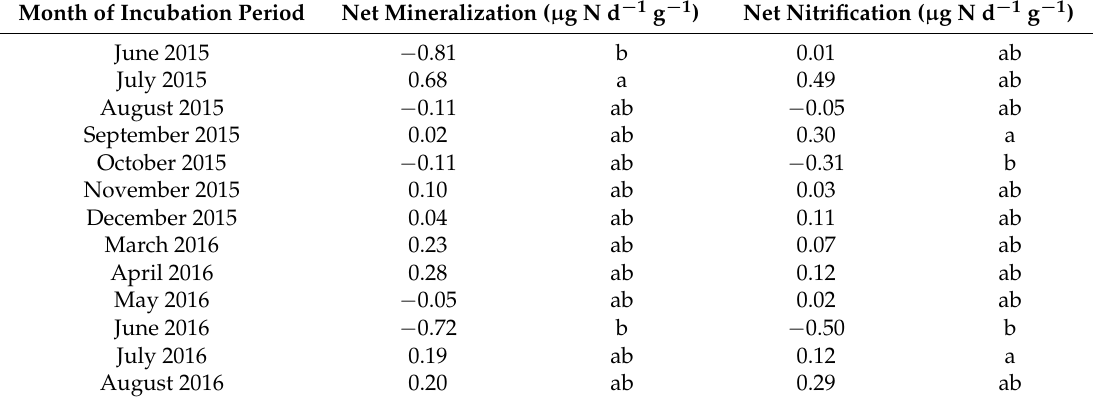
Table 3. Means of net mineralization and net nitrification ( µ g nitrogen (N) d − 1 g − 1 dry soil) averaged for shallow and deep halves of soil cores at seven bioswales ( n = 209). Letters indicate statistically significant differences among periods.